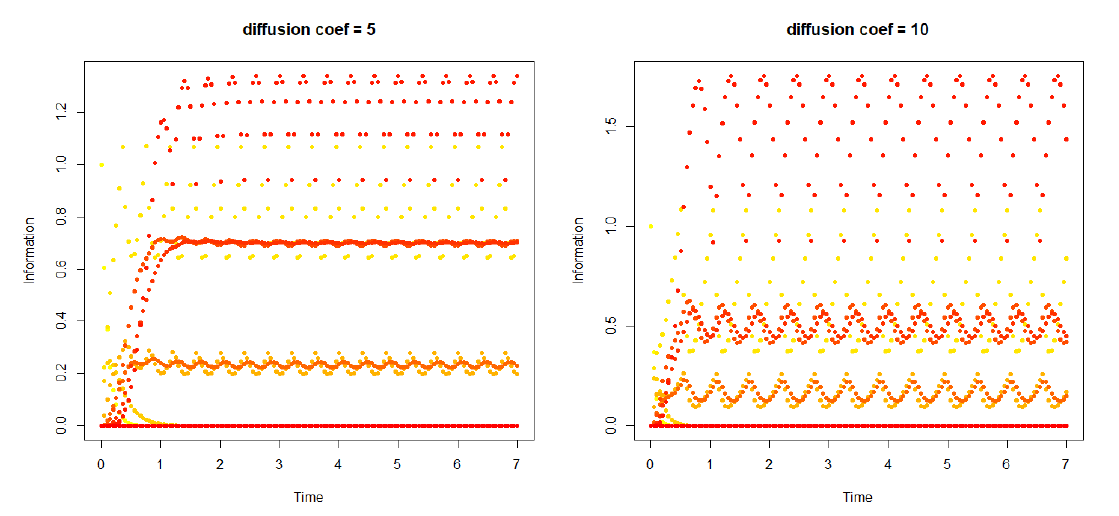
Figure 13. The information diffuses from node 1 ( f ( 0,1 ) = 1 while f ( 0, x ) = 0 for any x (cid:54) = 1) to node 10 with additional creation (to node 2) and destruction (to node 10) added. Here D = 5 ( left panel) and D = 10 ( right